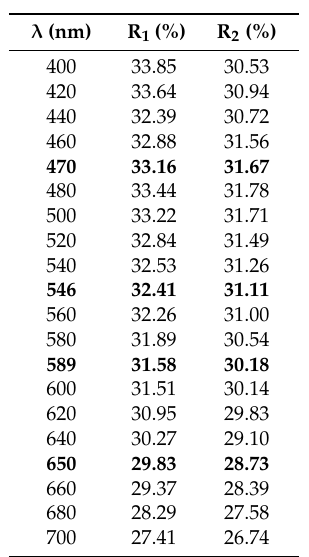
Table 1. Reflectance data for tsygankoite.